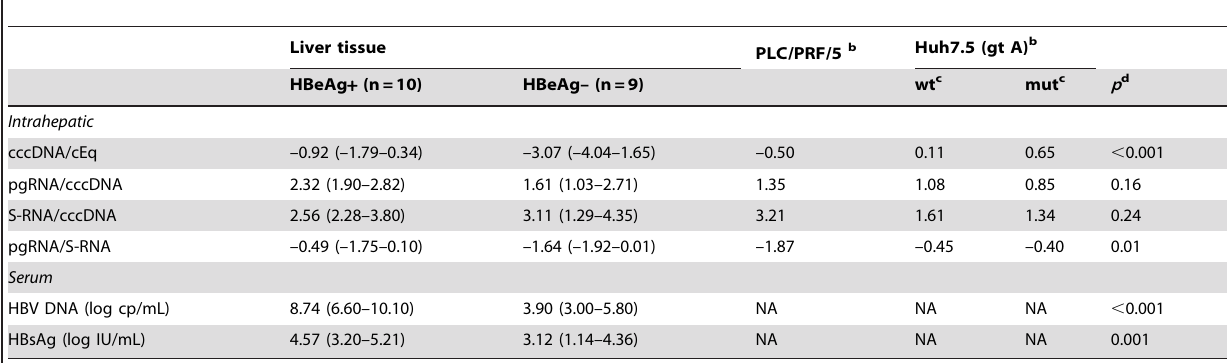
Table 3. HBV DNA and RNA levels in cell cultures and liver biopsies a